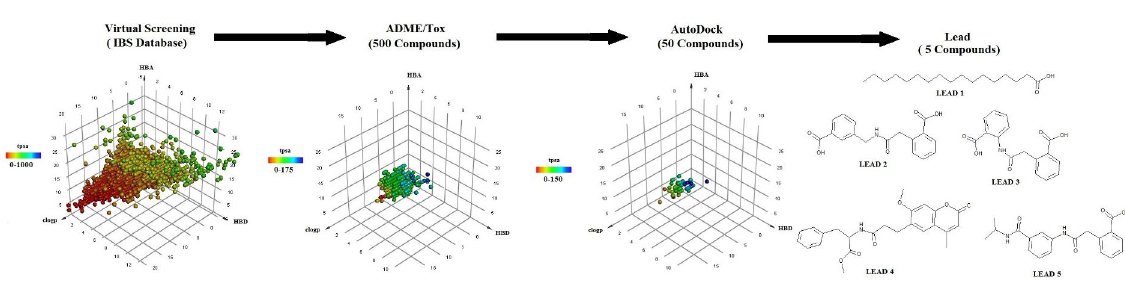
Figure 5: 3D point plot of four properties (HBA, HBD, clogP, and tpsa) of the compounds at different stages of drug discovery, showing the journey from ~ 50000 compounds to top five in accordance with Lipinski’s